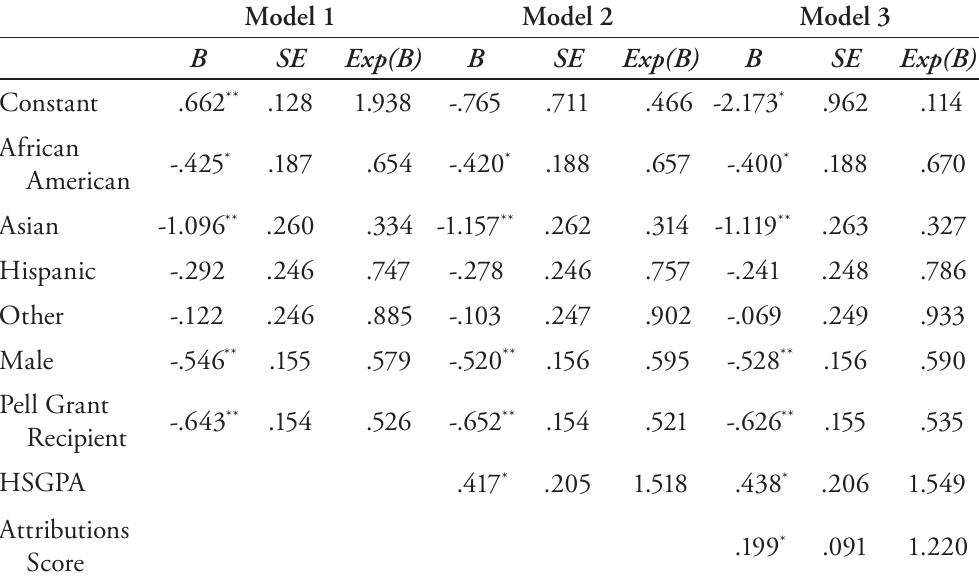
Table 6. Summary of the Hierarchical Logistic Regression Predicting Four- Year Degree